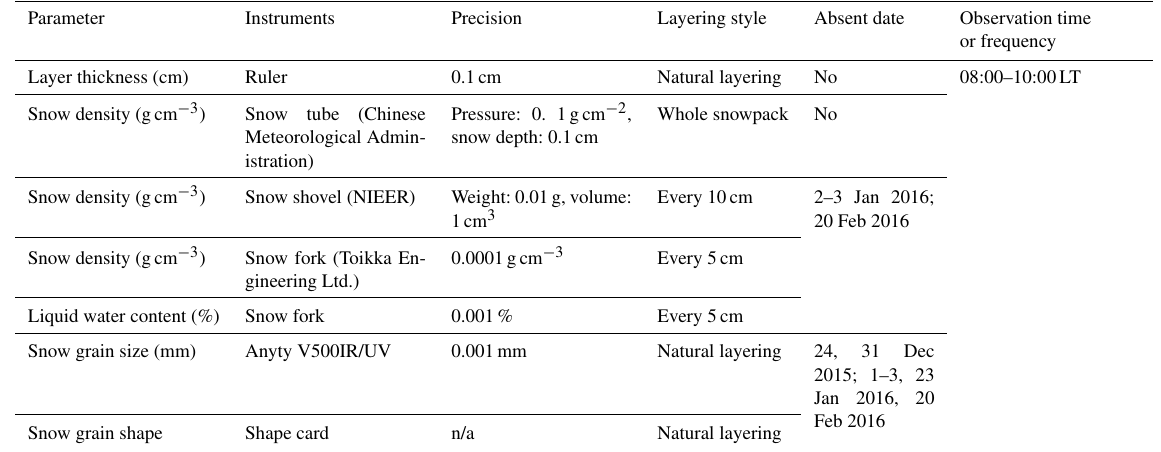
Table 3. Variables collected by manual daily snow pit measurement in Field 1 in Fig. 1, along with their observation instruments and observation time or